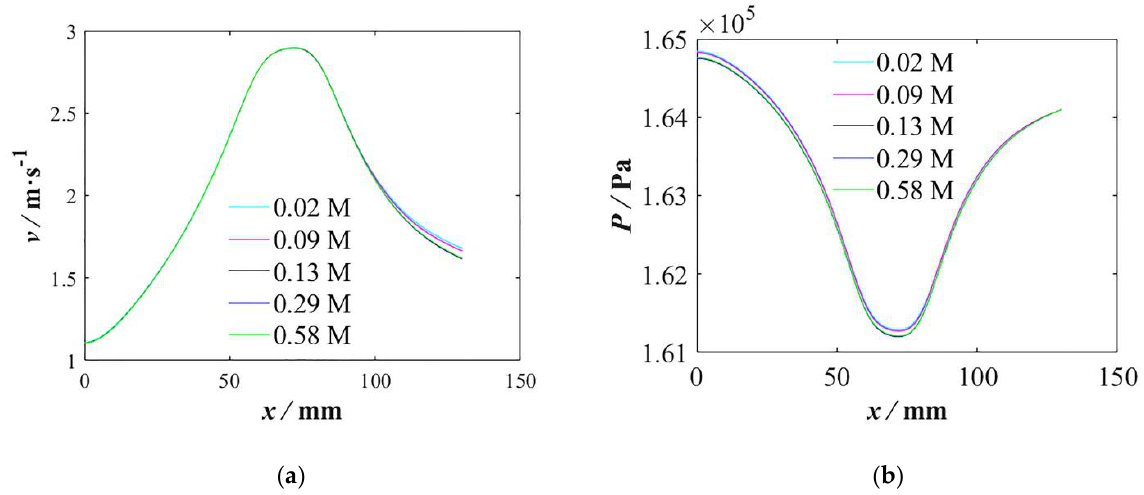
Figure 3. Mesh sensitivity analysis results of VT ( a ) velocity distribution ( b ) pressure distribution.